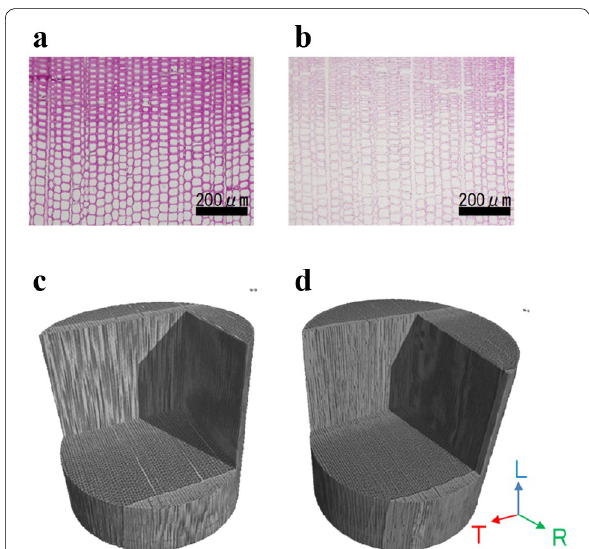
Fig. 6 a , b Optical microscopic images after PAS staining, and c , d 3-dimensional X-ray µCT images. a , c are obtained from untreated wood while b and d are from the colorless wood,